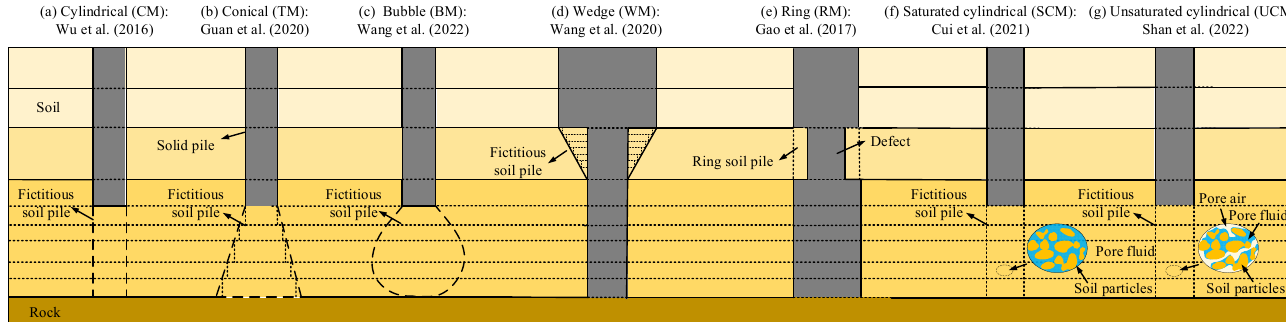
Figure 8. Stress and displacement of soil calculated by the fictitious soil pile model and the rigorous elastic theory: ( a ) principle stress; ( b ) displacement. 2.3. Progress in the 3D Soil–Pile Wave Propagation Theory Besides the wave reflection at the pile bottom, it is found the reflection of the trans- verse wave at the pile shaft could be significant as the dimension of the pile increases. Many studies reported intensive interferences when conducting low-strain integrity tests for pile foundations [69–72]. The formation mechanism of this so-called “high-frequency interference” was not theoretically revealed until the last decade. The 1-D rod theory is no longer capable of revealing the “high-frequency interference” caused by transverse wave propagation. Hence, utilizing viscoelastic continuum theory, Ding et al. [73,74] estab- lished a soil–pile interaction model capable of simulating the 3D strain wave propagation inside the pipe pile. Zheng et al. [75–77] investigated the high-frequency interference un- der axisymmetric loading conditions, where the high-frequency interference is mainly caused by the radially propagated strain wave. Subsequently, Zheng et al. [78] extended their studies to the non-axisymmetric cases and found the high-frequency interference caused by the circumferentially propagated strain wave more significant than that caused by the radially propagated strain wave. Dai et al. [79] studied the three-dimensional wave scattering of the soil–pile system induced by the vertical P wave, and derived an analytical solution to the equivalent Winkler model for vibrations induced by the seismic P wave. Meng et al. [80] discovered that the impedance of the pile would vary radially. In detail, the most significant dynamic stiffness would appear at the center of the pipe pile, whereas the most significant dynamic damping would appear at the outer radius of the pipe pile, as shown in Figure 9. Their mathematical model also illustrates the formation mechanism